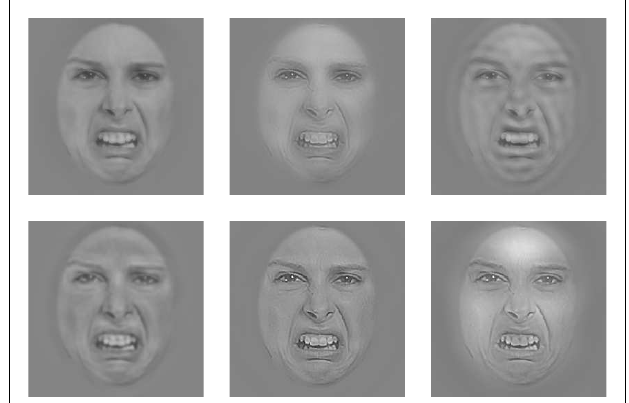
FIGURE 3 | Example of a face image filtered with the SF Bubbles technique on six hypothetical